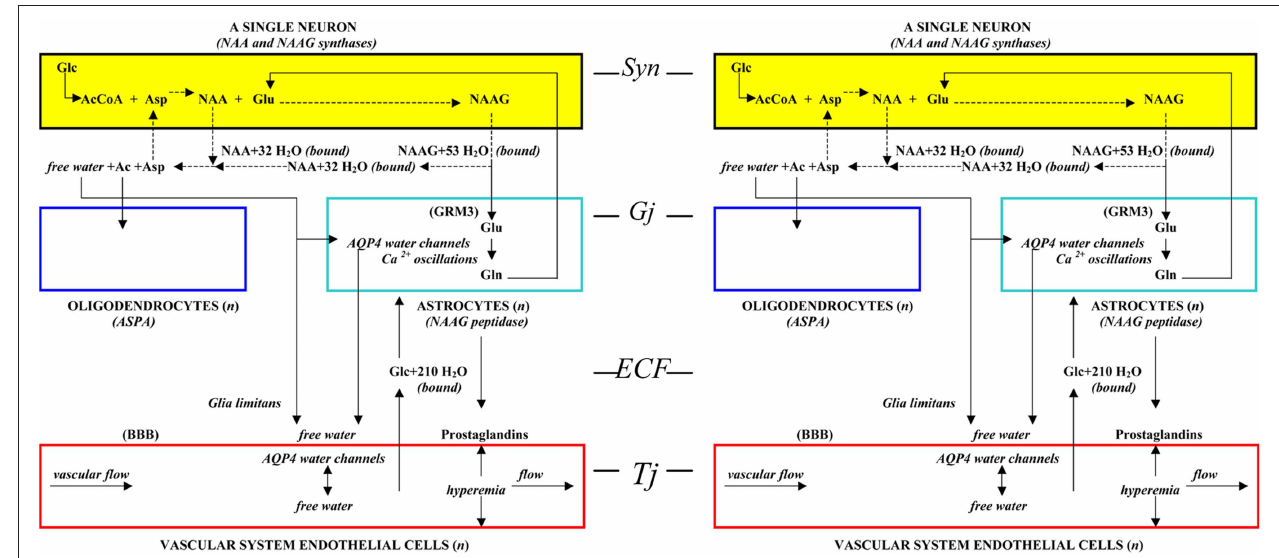
Figure 3 | The functional unit of the brain, two interconnected structural units, each containing a three-cell metabolic unit and a four-cell physiological operating system (from Baslow, 2010a).